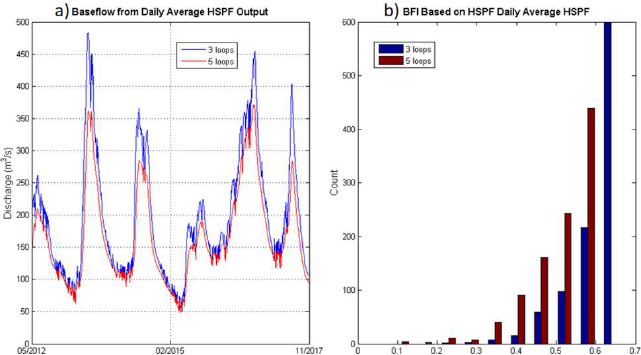
18 of 23 Figure 12. Baseflow index computed from daily 08:00 HSPF output and observations. 4. Discussion 4.1. Baseflow Index (BFI) The baseflow index computed using the method in [41] is sensitive to the number of times the input data are filtered. In [41], it is recommended that the algorithm is looped three times (n = 3) if the daily flow rates are used and nine times (n = 9) if hourly input is involved. However, in Figure 13a, we can notice that, if daily input is utilized, the separated baseflow time series is still ragged when n = 3, and the curve becomes reasonably smooth when n = 5. For hourly inputs (Figure 14), when n = 9, the separated baseflow already looks reasonably smooth. The BFIs computed using different n values and different timescales are reported in Table 13. Hourly input with n = 9 yields an estimation consistent with the case where daily input and n = 3 are used (BFI ~0.60), yet, when n is increased, at least for the daily inputs, the BFI decreases. The selection of n could still be subjective, depending on the user’s judgment concerning whether the separated baseflow is “smooth” enough. In [46], the authors constructed a global map of BFIs based on the observations from 3394 catchments utilizing a 1-hidden-layer artificial neural network. According to this map (Figure 11 in [46]), the BFI of our catchment lies between 0.45 and 0.65. Almost all the values listed in Table 13